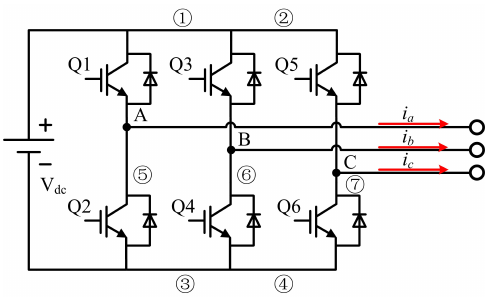
Figure 3. The schematic diagram of conventional three-phase system using the PWM-VSI.